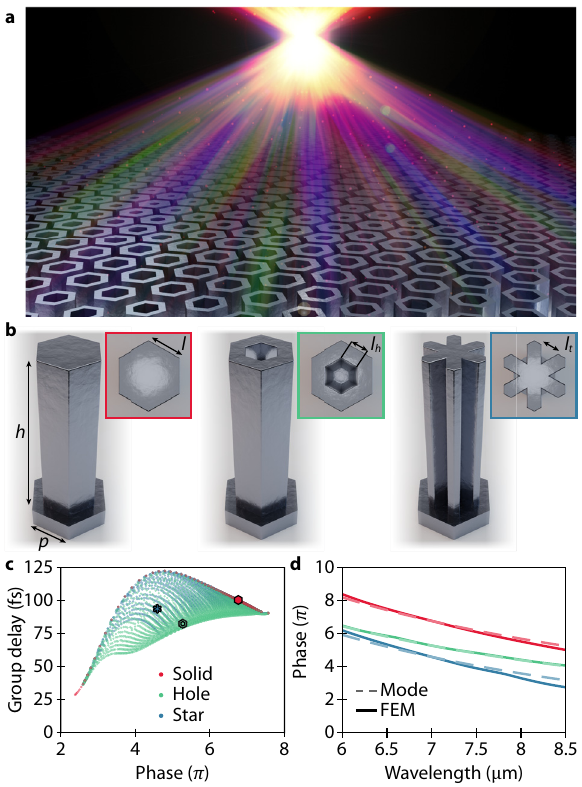
Figure 1: Principle of designing an achromatic metalens. (a) An achromatic metalens with dispersionless focusing. (b) Schematic of three different metalens elements consisting of Si nanopillars with the height of h = 8 μ m and unit cell periodicity p = 2 μ m. The displayed shape of elements has varying in-plane geometrical parameters ( l , l h , l t ). (c) Phase and group delay for all elements in our library at the center frequency ω 0 = 42.62 THz ( λ ≈ 7 μ m). (d) A comparison of phase response for different meta- elements from eigenmode solutions versus fi nite-element method (FEM) calculations. The red curve represents a “ solid ” element; the green a “ hole ” element; and the blue a “ star ” elementwhose library positions are speci fi ed in